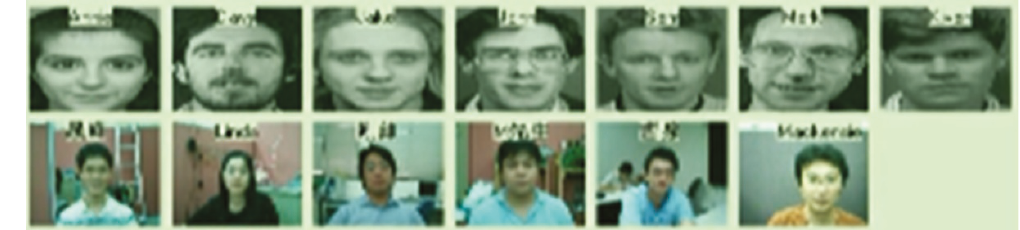
Figure 21: Examples of clients in the database.